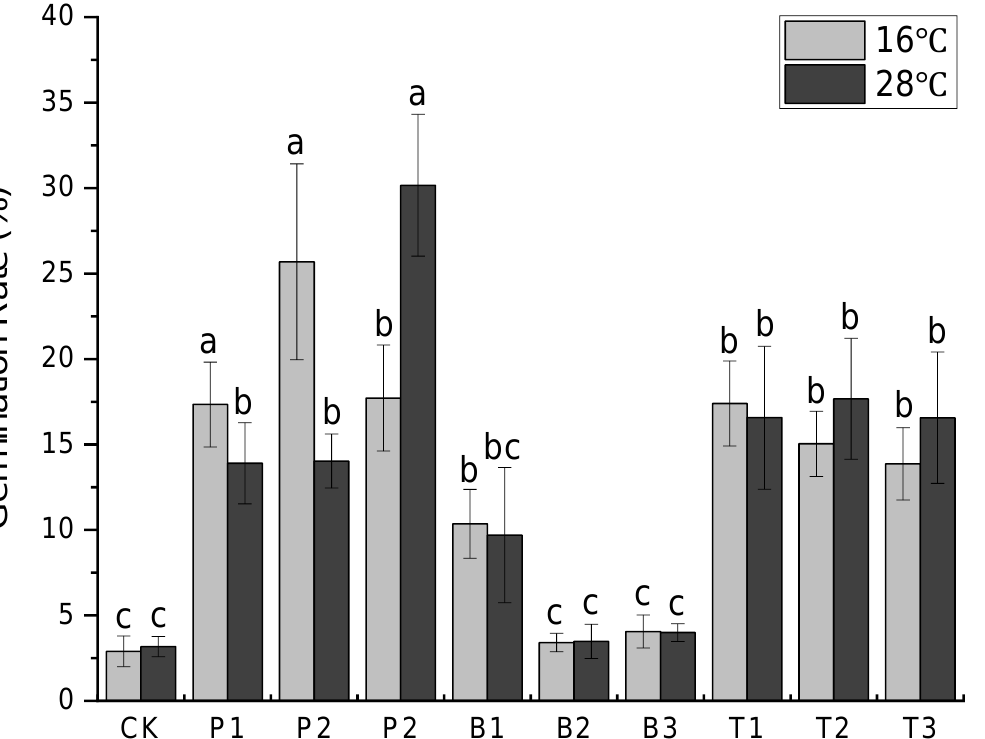
Figure 1. Germination rate of litchi pollen in different concentrations of reagents. CK: Clearwater P1, P2, P3: putrescine 20 mg/L, 40 mg/L, 60 mg/L. B1, B2, B3: boric acid 0.1%, 0.2%, 0.3%. T1, T2, T3: Nano-titanium dioxide 300 mg/L, 600 mg/L, 900 mg/L. Different letters indicate statistical differences between treatments ( p ≤ 0.05).